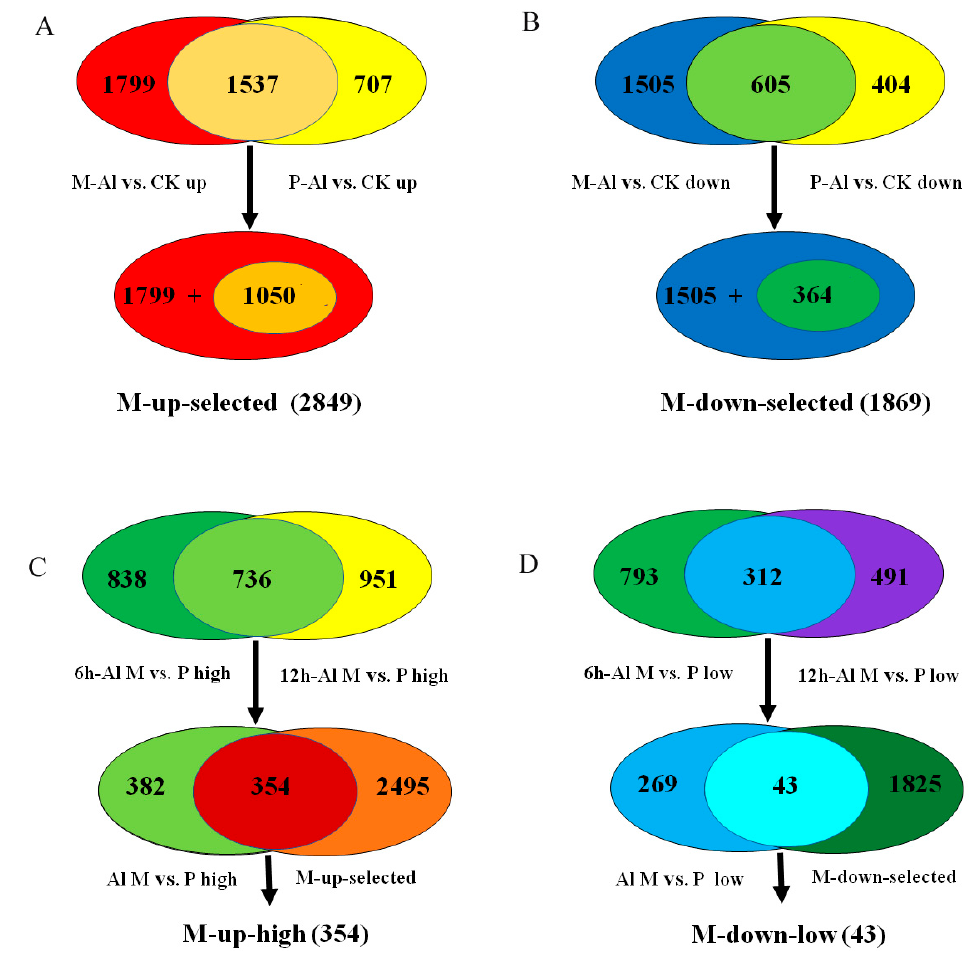
Figure 3. The selection procedure for Al-tolerance related genes in the lists of M-up-selected, M-down-selected, M-up-high and M-down-low. ( A ) The M-up-selected list includes 2849 Al-induced genes specific to M (1799) or with more up-regulation in M than P (1050). ( B ) The M-down-selected list includes 1869 Al-repressed genes specific to M (1505) or with more down-regulation in M than P (364). ( C ) The M-up-high list includes 354 genes with higher relative expression levels in M than P under Al treatment and more up-regulation by Al in M than P. ( D ) The M-down-low list includes 43 genes with lower relative expression levels in M than P under Al treatment and more down-regulation by Al in M than P.